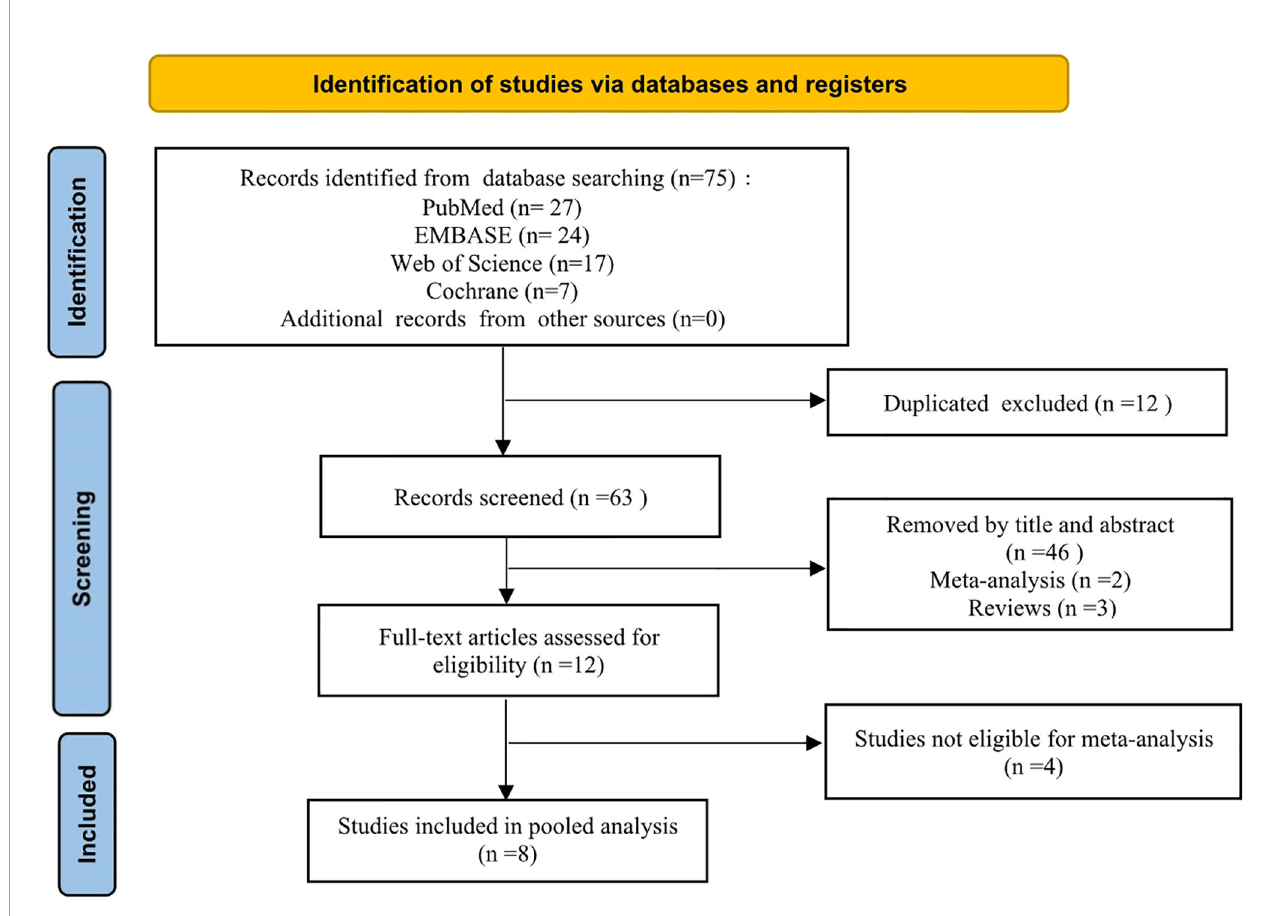
FIGURE 1 | Flow diagram of the meta-analysis literature search and study